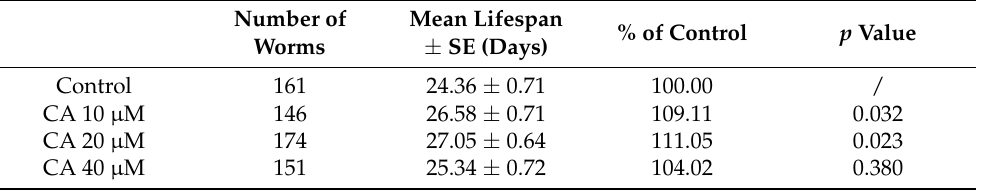
Figure 1. CA increases lifespan in C. elegans . ( A ) Structural diagram and synthesis steps of aspirin curcumin ester to form CA. Wild-type L4 stage worms were treated with 0.1% DMSO (vehicle control) or ( B ) with CA (10, 20, 40 µ M, n > 151 in each group, p = 0.03, 0.02, 0.38) or ( C ) with rapamycin (2 nM) or CA (5, 10, 20 µ M, n > 165 in each group, p < 0.05). Their survival was monitored from the first day of the L4 stage until death, as described in the Methods. Assays were performed for each condition at least three times. A representative trial is shown. The difference was examined with the log-rank test. Table 1. Effect of CA on the mean lifespan of C. elegans